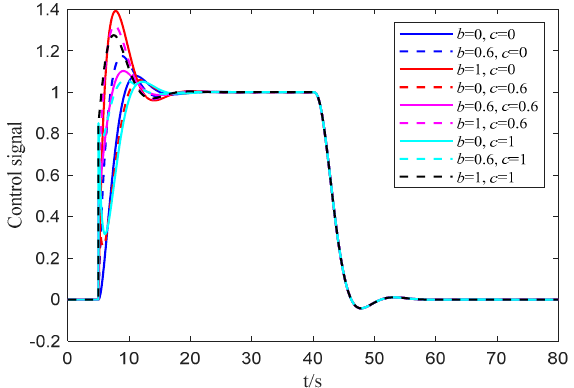
Figure A2. The output of tracking performance with different b and c . Processes 2019 , 7 , x FOR PEER REVIEW 31 of 33